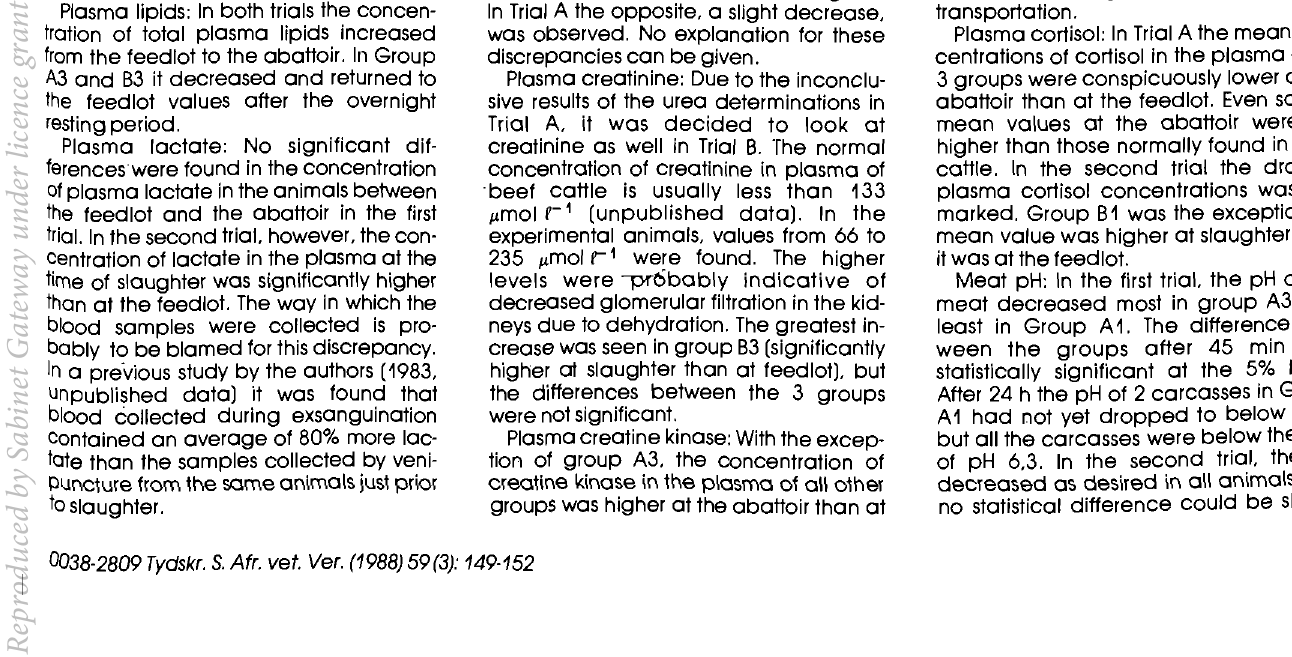
Table 3: The mean pH (and the range within each group) of the meat 35·45 min and again 24 h after slaughter